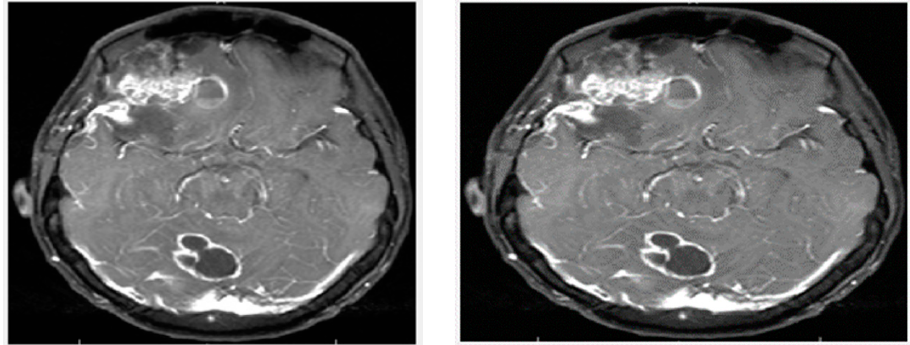
Figure 5. MRI image after preprocessing: ( Left ) Original image and ( Right ) Enhanced image. To increase the sharpness and smoothness as well as for edge enhancement, a filter operation has been used for the processing of the image. In this proposed method, the anisotropic filter has been applied to the image instead of any other filter such as the Gaussian filter median and mean filter. The reason behind this is that while noise can be reduced better by using a mean filter, the edge cannot be preserved. On the other hand, the Gaussian filter makes the image blurry [13] while preserving the edge. The median filter